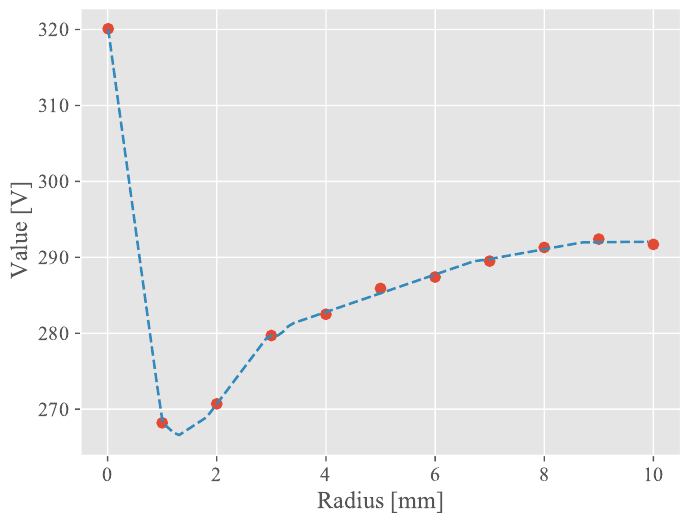
Figure 11. Proxy model with ReLU neural network (blue line) applied to the data presented in Table 2 (red